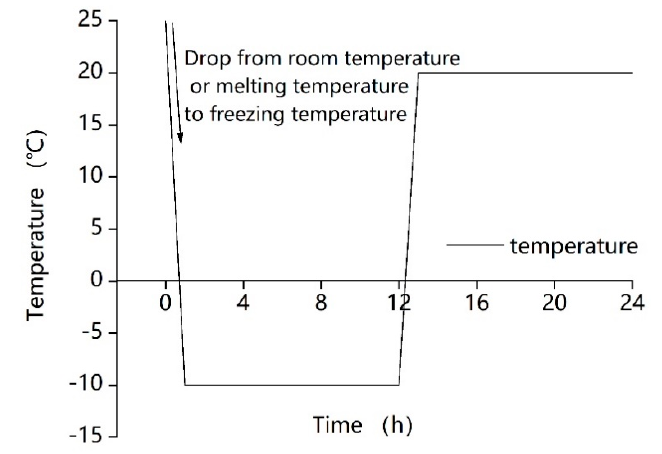
Figure 2. Temperature curve of the one-day freeze–thaw cycle.